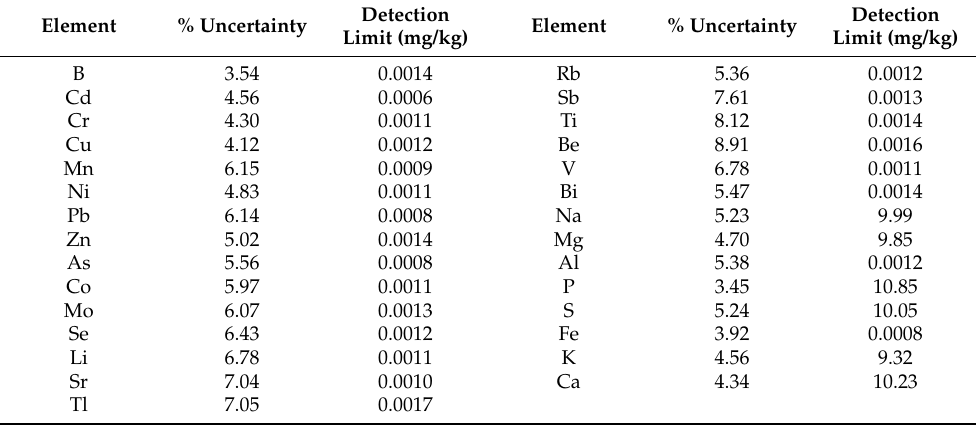
Table 2. Uncertainty of measurement (%) and detection limits for the analyzed elements by induc- tively coupled